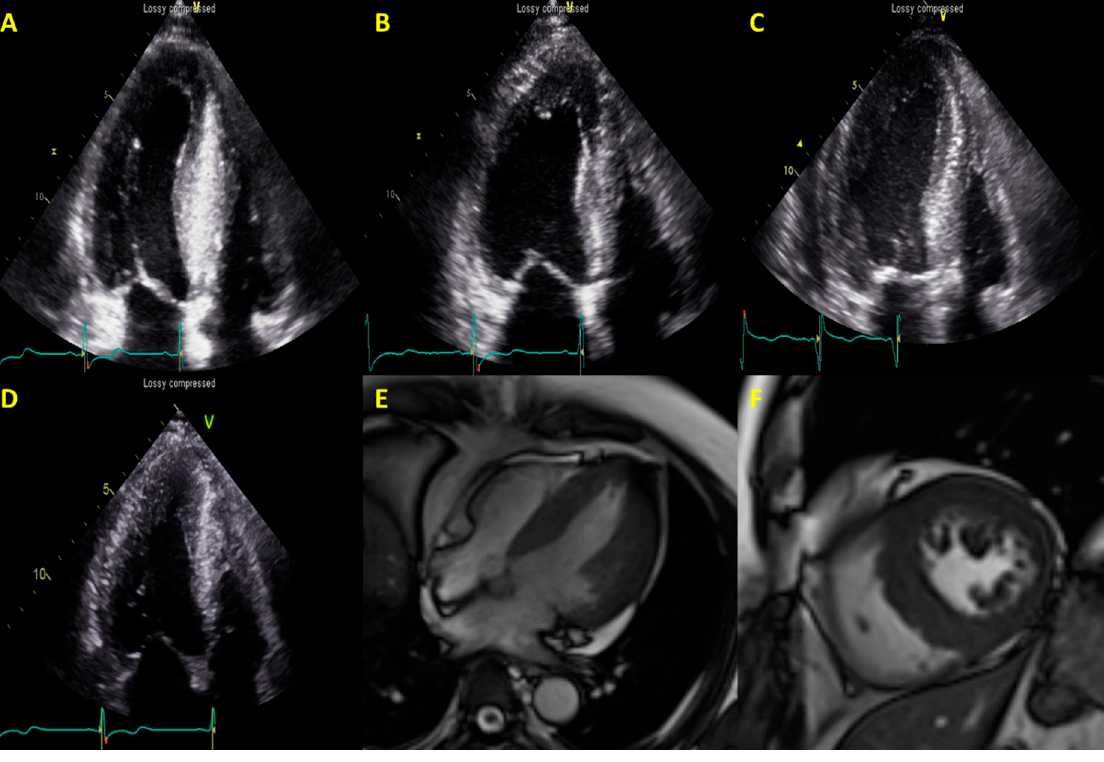
Figure 1. Sample illustration of imaging phenotypes of Hypertrophic cardiomyopathy (HCM) on echocardiography: septal hypertrophy ( A ), septal and apical hypertrophy ( B ), concentric hypertrophy ( C ), apical hypertrophy ( D ), and representative cardiac magnetic resonance (MR) images of HCM ( E , F ).